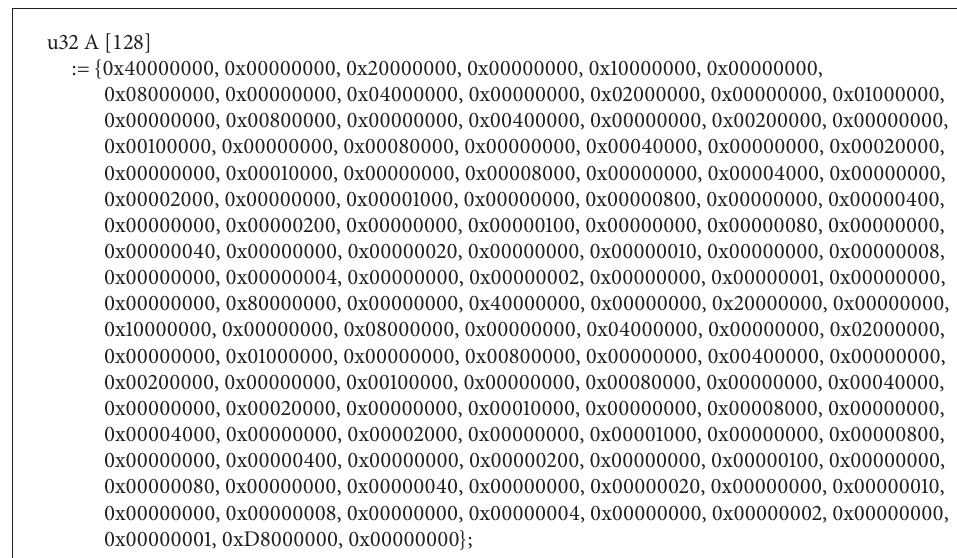
Algorithm 5: Initial contents for matrix 𝐴 .